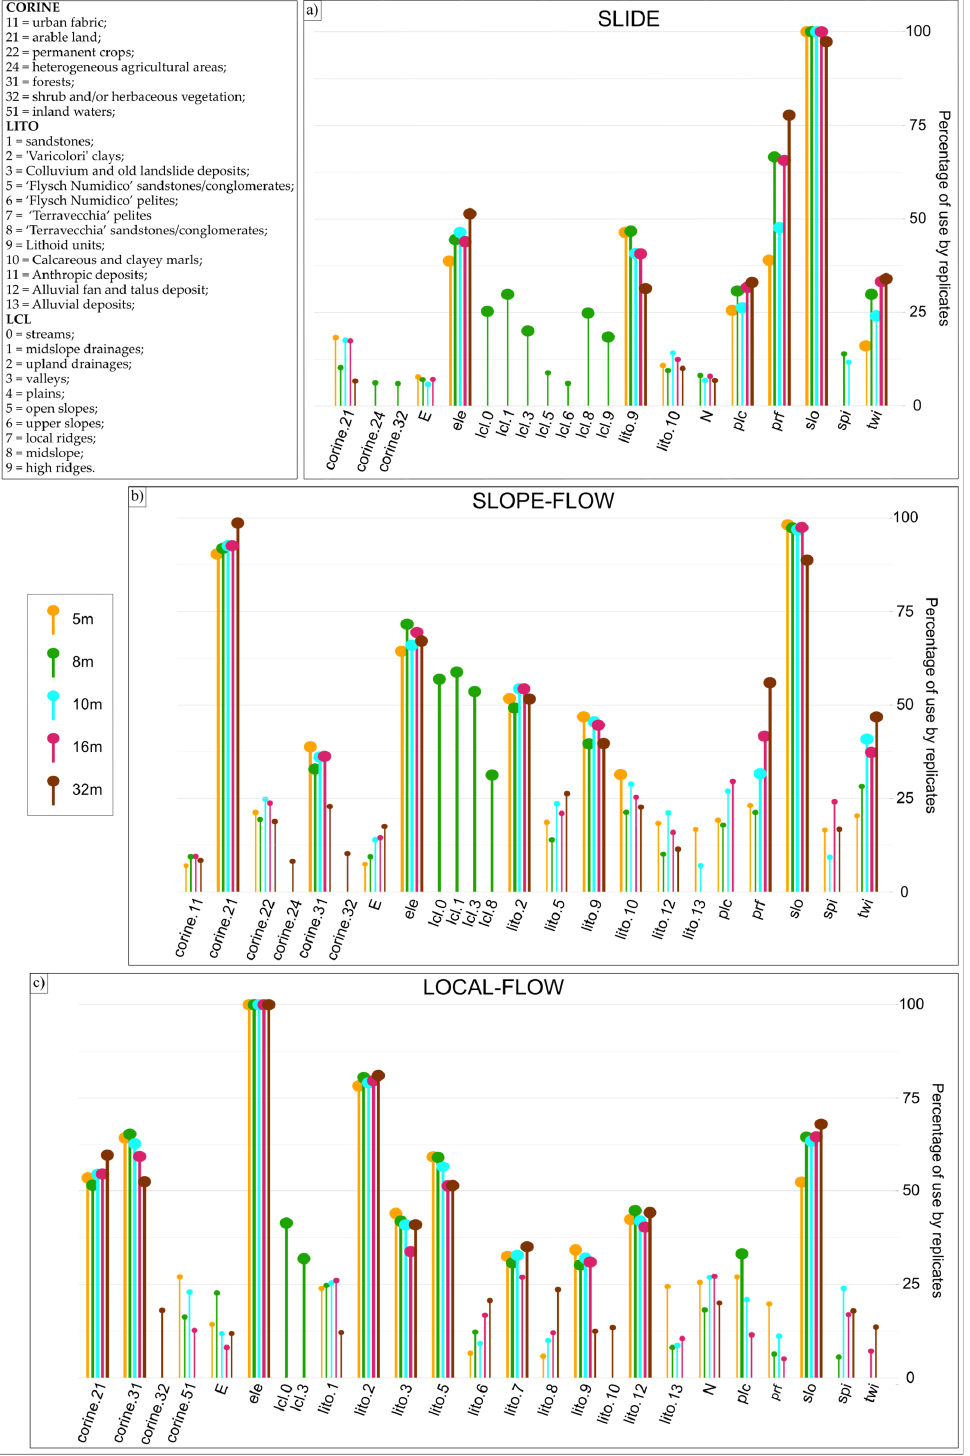
Figure 5. Comparison of the variable importance of the models for ( a ) slide type, ( b ) slope flow and ( c ) local flow. The thicker lines identify the variables which are employed for the 30% of replicates.